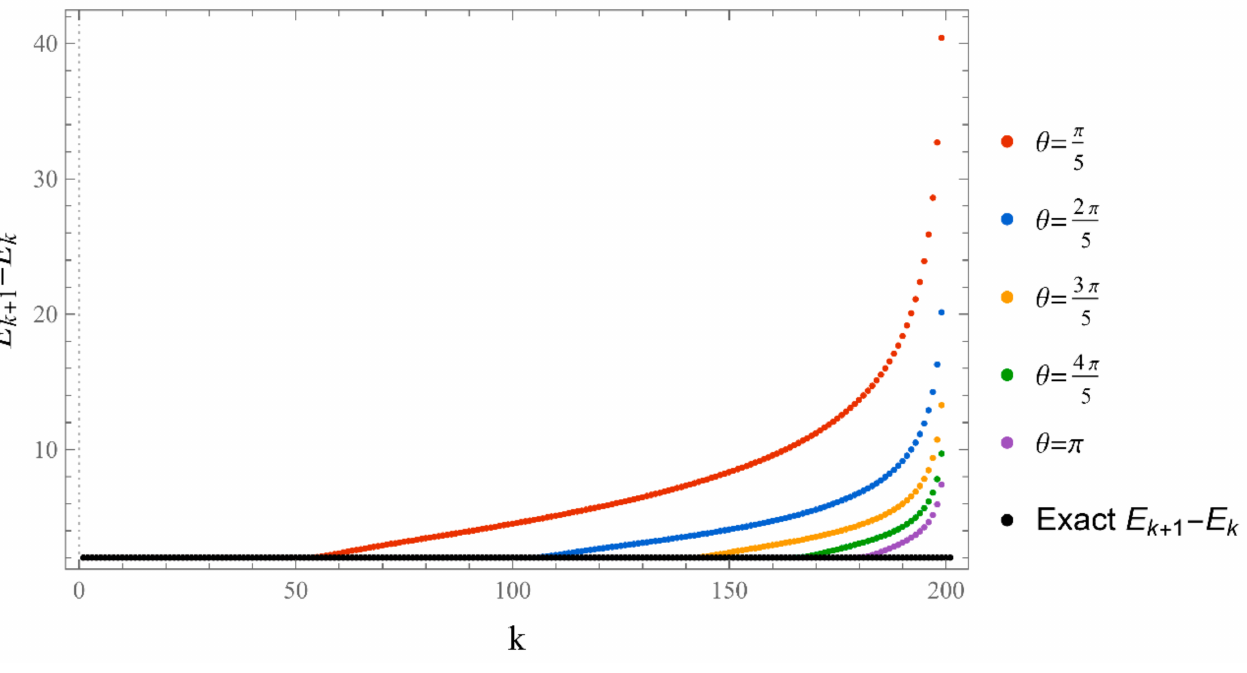
Figure A16. The difference between consecutive zeros of P N ( E ) for N = 200. We took ω = 1, µ = 5, for different values of θ . The difference is constant, which matches the theoretical value of 2 ω . However, we get better convergence as θ